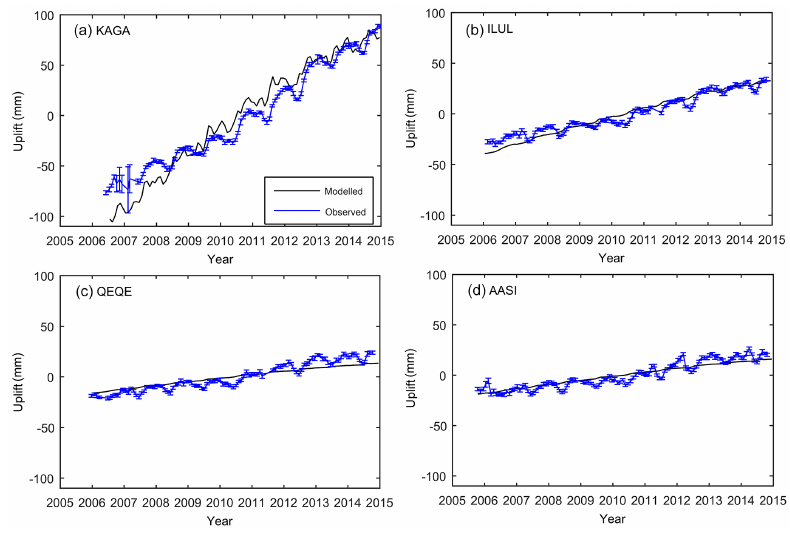
Figure 5. Observed versus modelled uplift in millimetres for the stations KAGA (a) , ILUL (b) , QEQE (c) , and AASI (d) . The positions of the four GPS stations are presented in Fig.